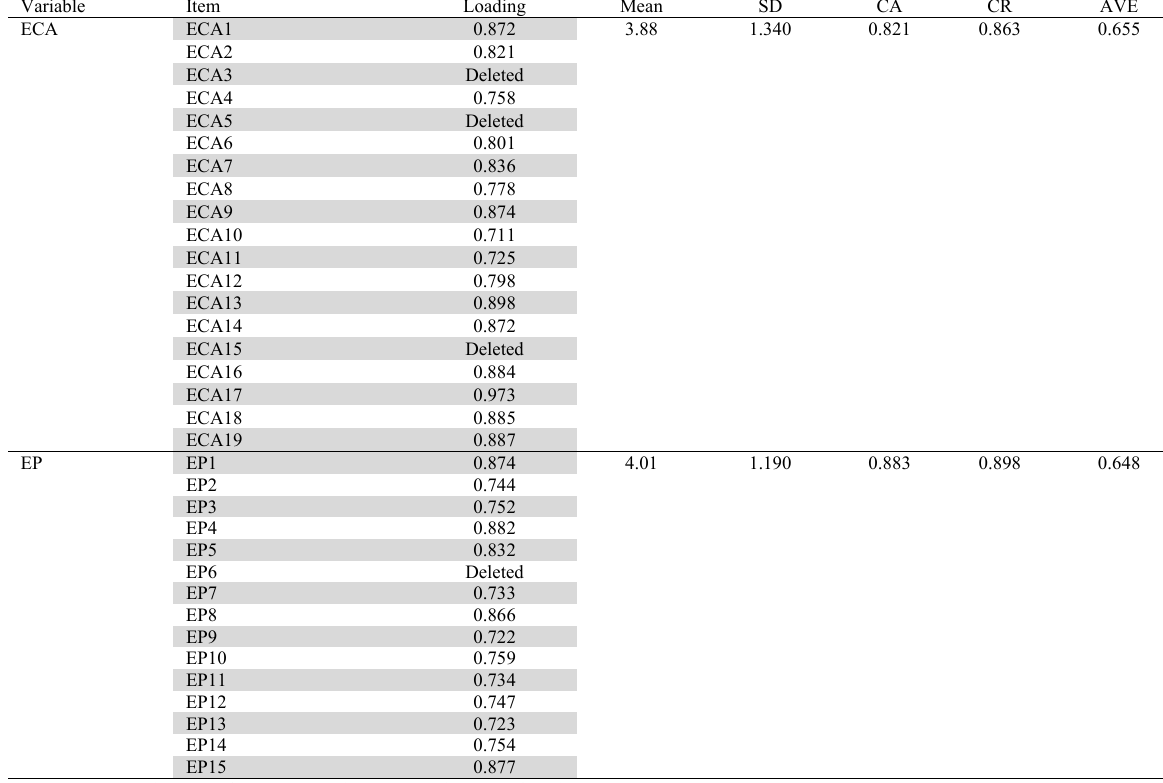
Descriptive and measurement model evaluation results Variable